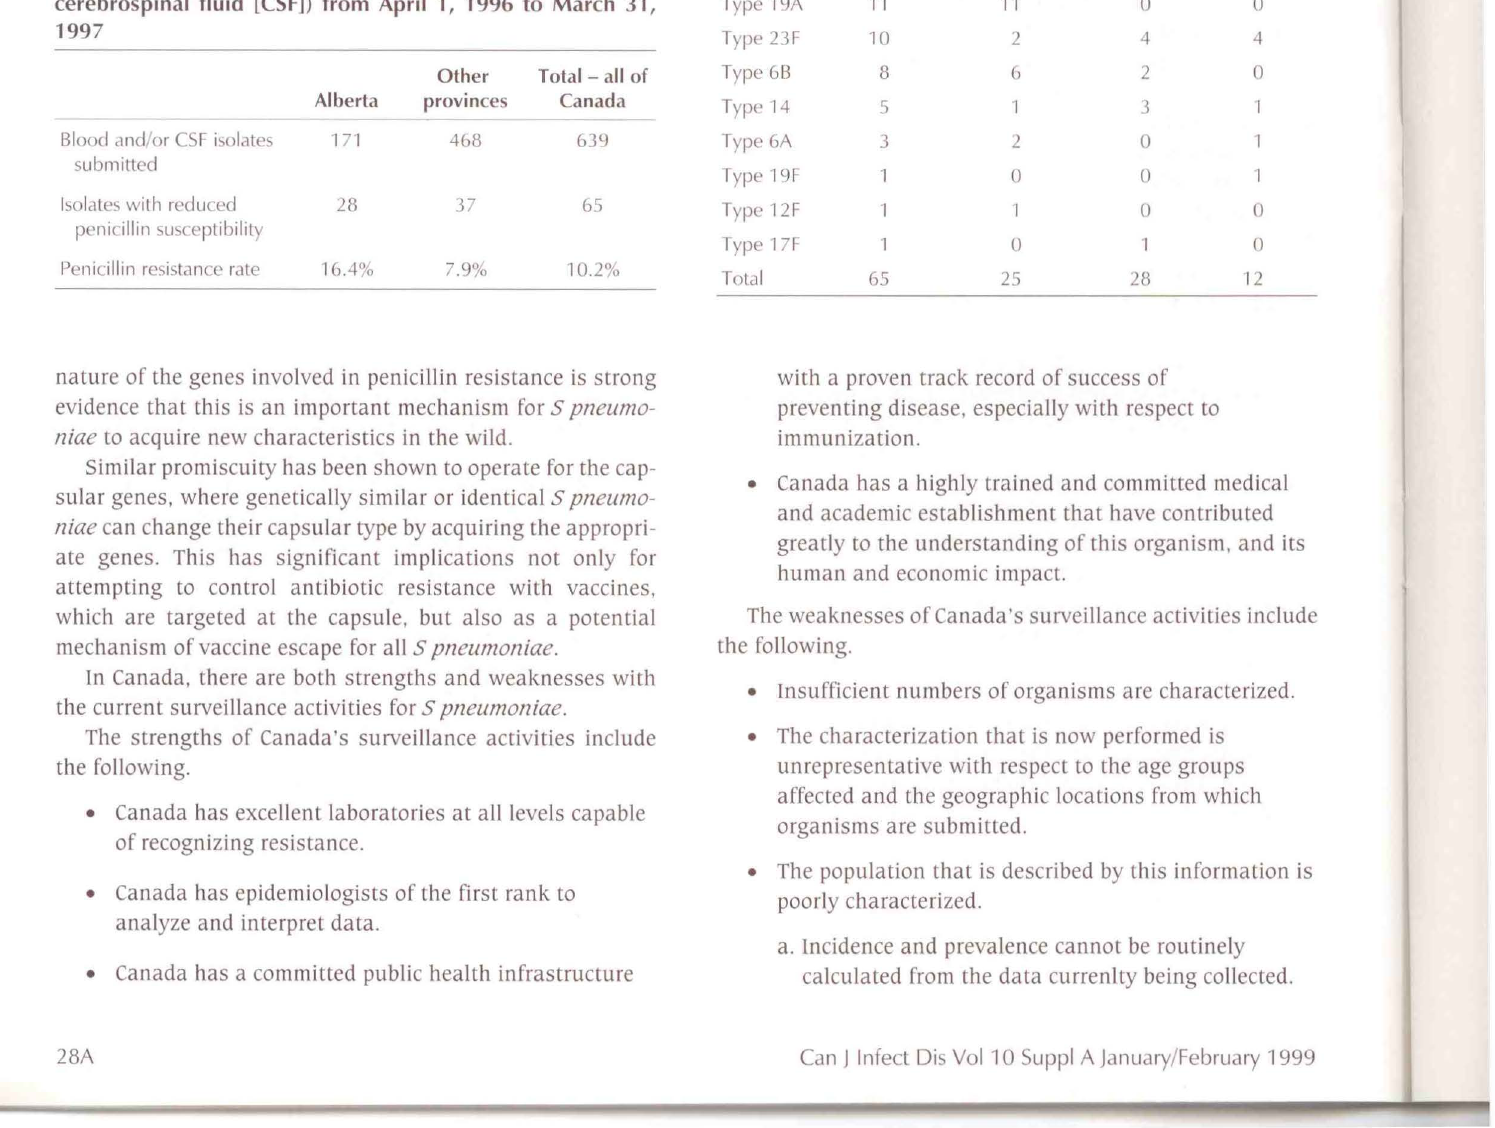
Serotype distribution and level of resistance for strains with reduced penicillin susceptibility, collected from April 1, 1996 to March 31,